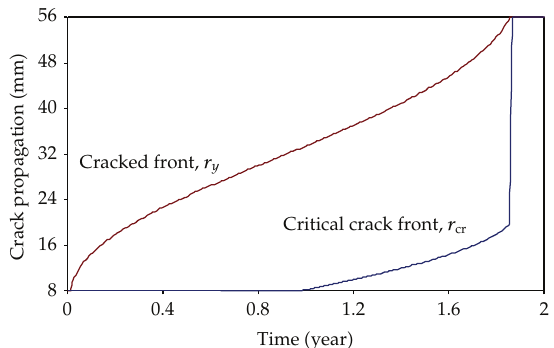
Figure 6: Propagation of cracked front (cid:5) r y (cid:6) and critical crack front (cid:5) r cr (cid:6) with time t .